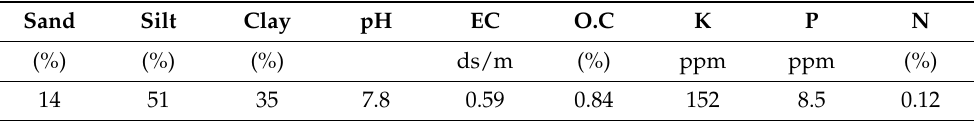
Table 1. Some physical and chemical characteristics of the field soil. Sand Silt Clay pH EC